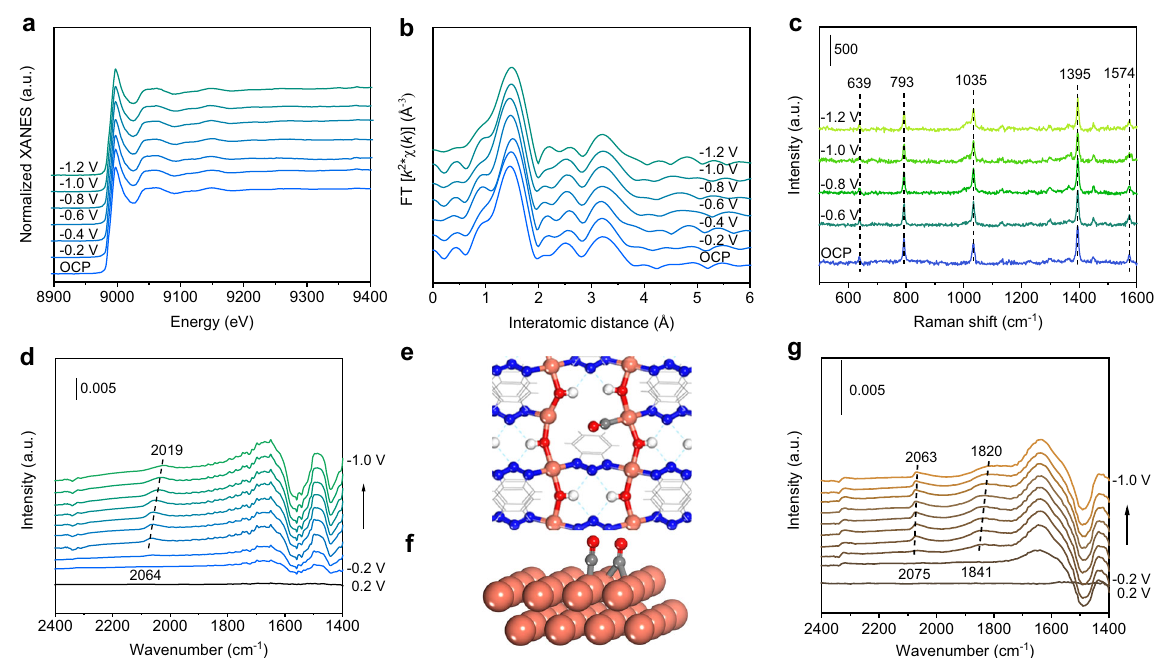
Fig. 3 | In-situ/Operando characterization of Cu(OH)BTA for CO 2 RR. Operando CuK-edgeXANES( a )andEXAFS( b )ofCu(OH)BTAattheappliedpotentialsof − 0.2 to − 1.2V under CO 2 atmosphere. c In situ Raman spectra of Cu(OH)BTA at the applied potential of − 0.6 to − 1.2V under CO 2 atmosphere. The peaks at 639, 793, 1035, 1395, and 1574cm − 1 correspond to the vibrational modes of molecular structure in Cu(OH)BTA. d In situ ATR-SEIRAS spectra of Cu(OH)BTA in CO 2